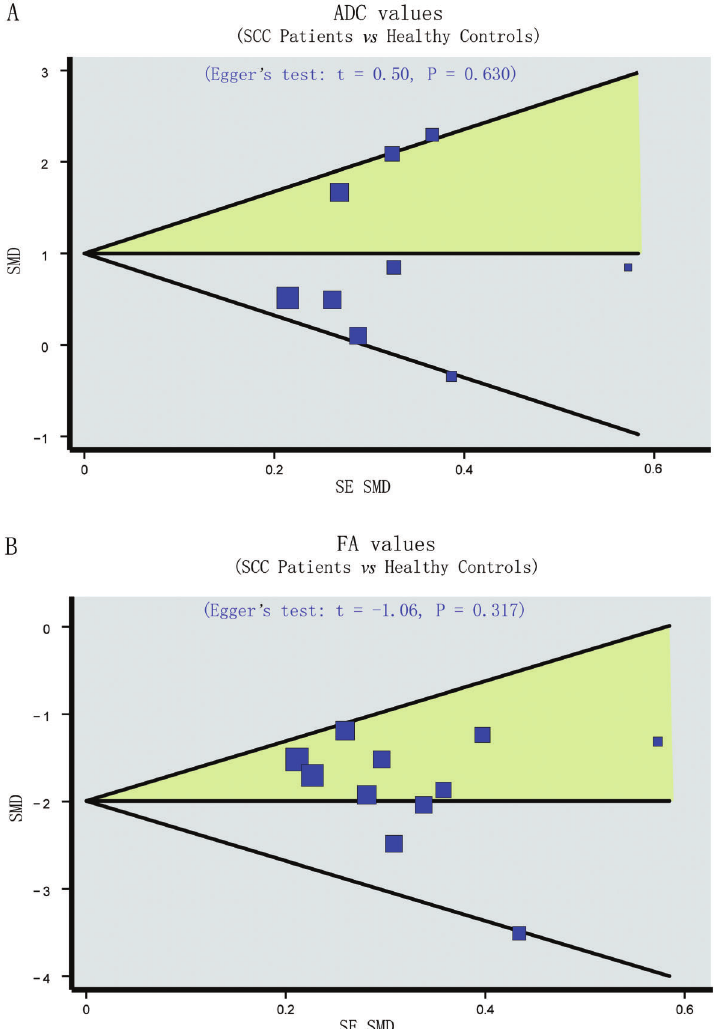
Figure 5. Funnel plot of publication biases on the difference in the frequency of the apparent diffusion coef fi cient (ADC) and fractional anisotropy (FA) values between patients with spinal cord compres- sion (SCC) and healthy subjects (A, ADC; B, FA value). See Figure 1 for reference